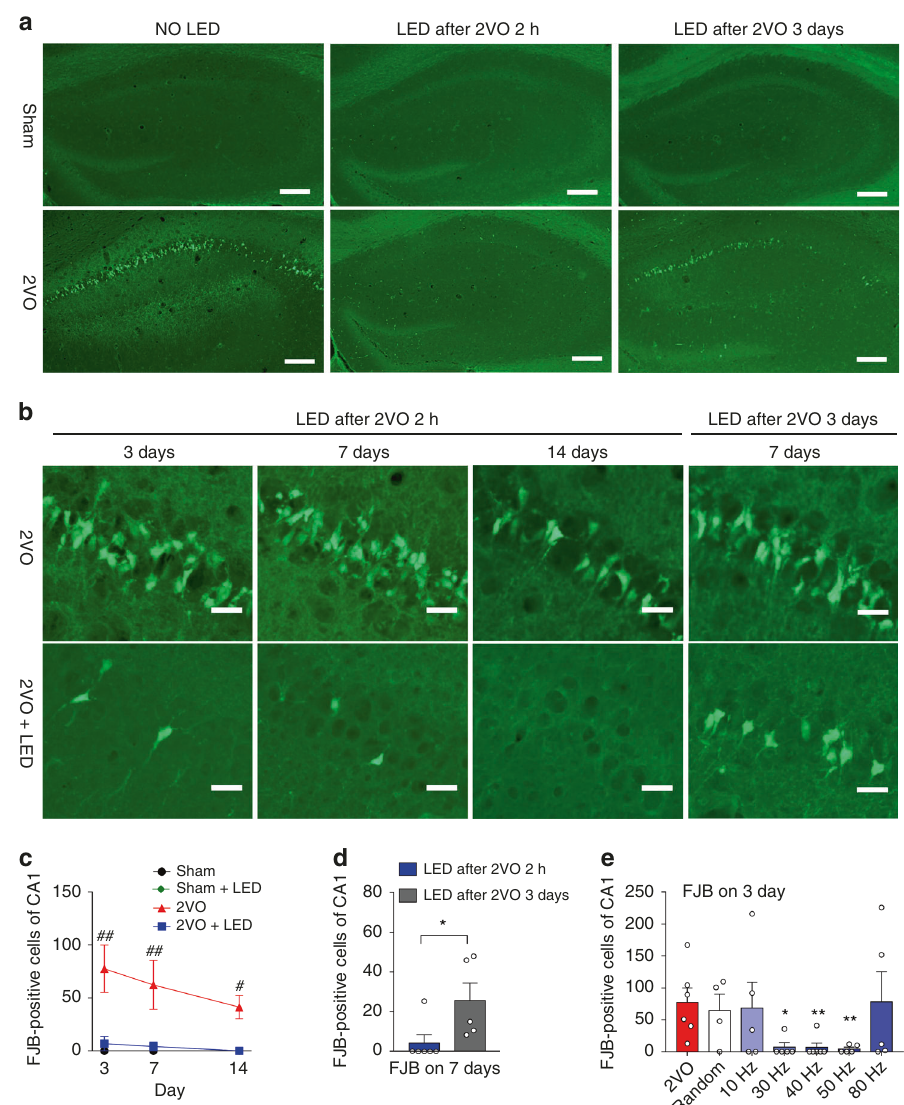
Fig. 2 Protection to CA1 neurons conferred by 40 Hz light treatment. a Coronal brain sections were stained with FJB. Hippocampal areas were shown in a highlighting 2VO-induced CA1 degenerating neurons (bright green colored cells). Scale bars = 50 µ m. b Enlarged CA1 area from 3 d, 7 d, and 14 d after 2VO with or without 40 Hz light treatment. Scale bars = 20 µ m. The last column of b showed 40 Hz light treatment at 3 d after 2VO. c and d Quanti fi cation of CA1 FJB positive neurons within CA1 ( n = 6 mice each group in c ; LED after 2VO 2 h: n = 6 mice; LED after 2VO 3d: n = 5 mice). e 2VO mice were treated with different rhythmic frequencies, and arrhythmic frequency of lights and FJB staining was performed 3 d after 2VO. n = 6 mice in 2VO and 40 Hz groups; n = 4 mice in Random group; n = 5 mice in other groups. Data represent the mean ± SEM. Error bars indicate SEM. ## indicates a comparison between 2VO and 2VO + LED group. *indicates a comparison between 2VO + LED group received 40 Hz light 2 h or 3 d after 2VO surgery, and ** in panel e indicates a comparison between the random group and 2VO mice received different frequencies of light treatment (*, # P < 0.05, and ** P < 0.01). The test used in c : 2ANOVA with LSD ’ s post hoc analysis; d Two-tailed unpaired t-test; e 1ANOVA with Dunnett ’ s post hoc test. Source data are provided as a Source Data fi